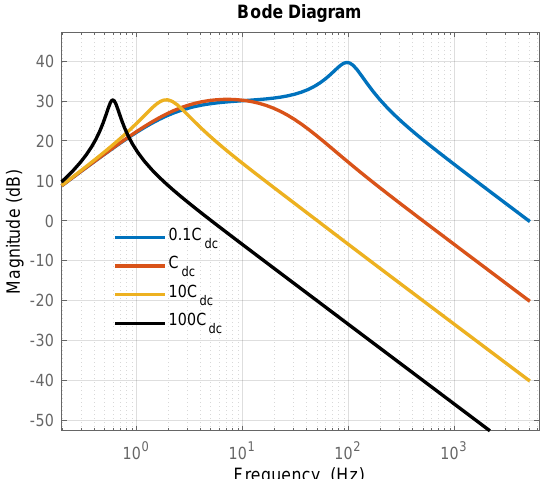
Figure 24. Input impedance sensitivity to total DC capacitance with capacitances 0.1 × , 1 × , 10 × , 100 × C DC , bus at both terminals, where C DC , bus is the nominal bus capacitance of 300 µ